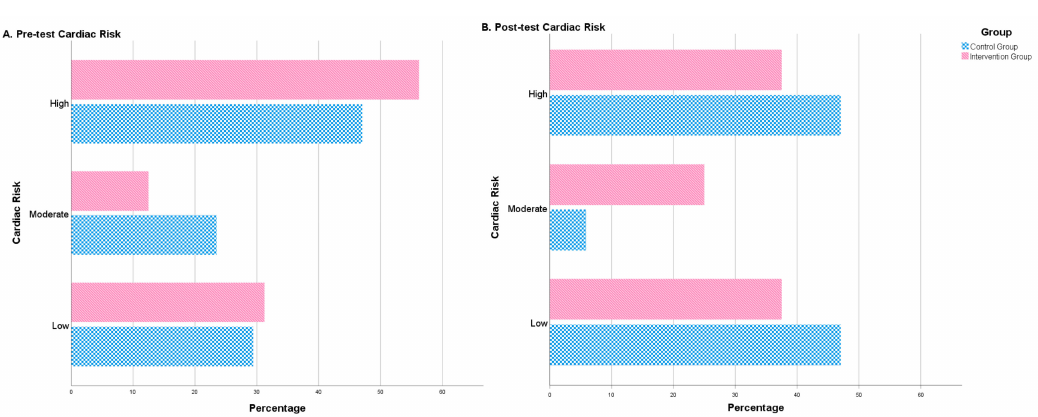
Figure 2. Cardiac risk (percentage of patients) before treatment (pre-test cardiac risk) and after treatment (post-test cardiac risk). Number of patients (in percentage) with low, moderate or high cardiac risk before and after the intervention. The figure shows the di ff erences between the control group (blue) and the intervention group